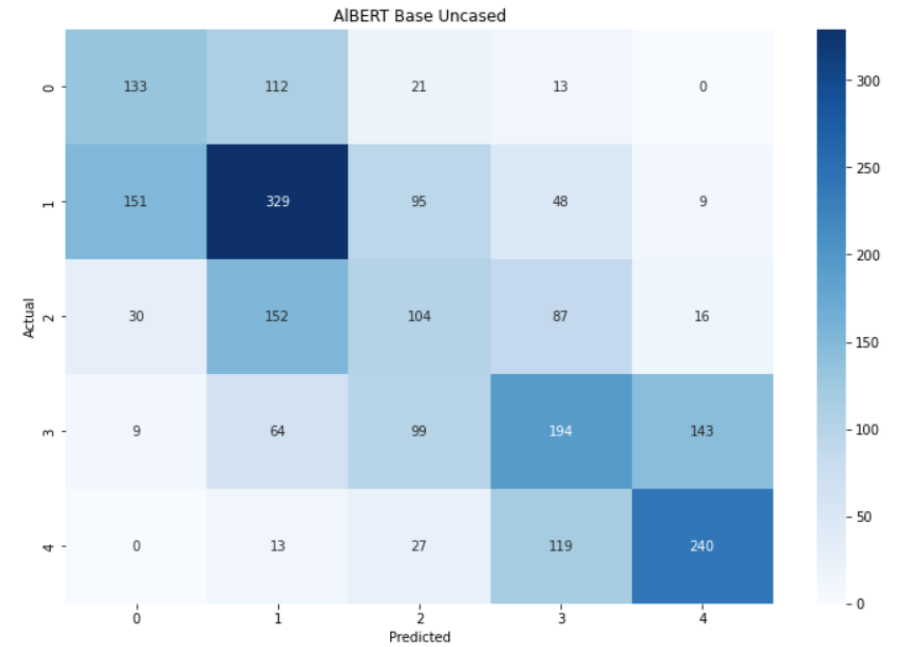
Figure 12. Confusion matrix for